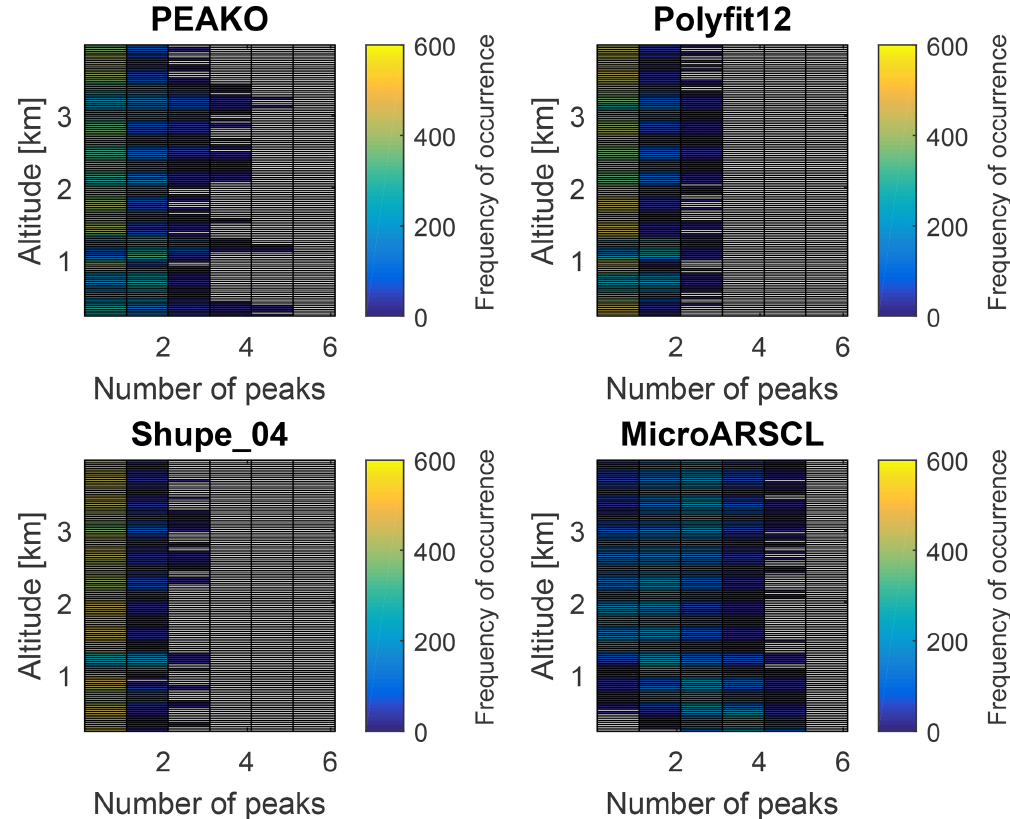
Figure A3. Like Fig. 6 but for the case study period on 16 February 2014, 0.66–0.92UTC, at 0–4km altitude.